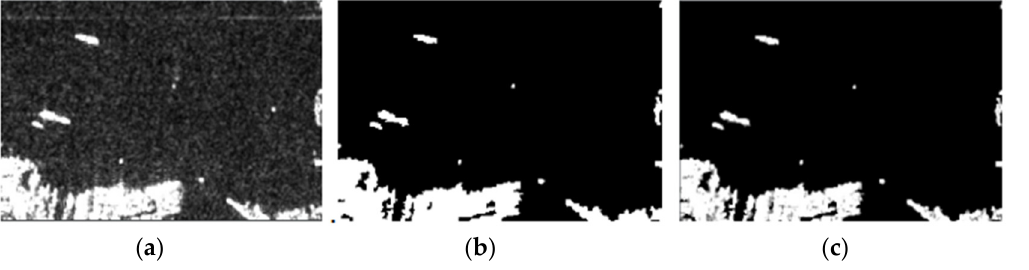
Figure 8. Object segmentation results: ( a ) Original image; ( b ) Binarized image; ( c ) After segmentation, it only contains images of coasts and ships.